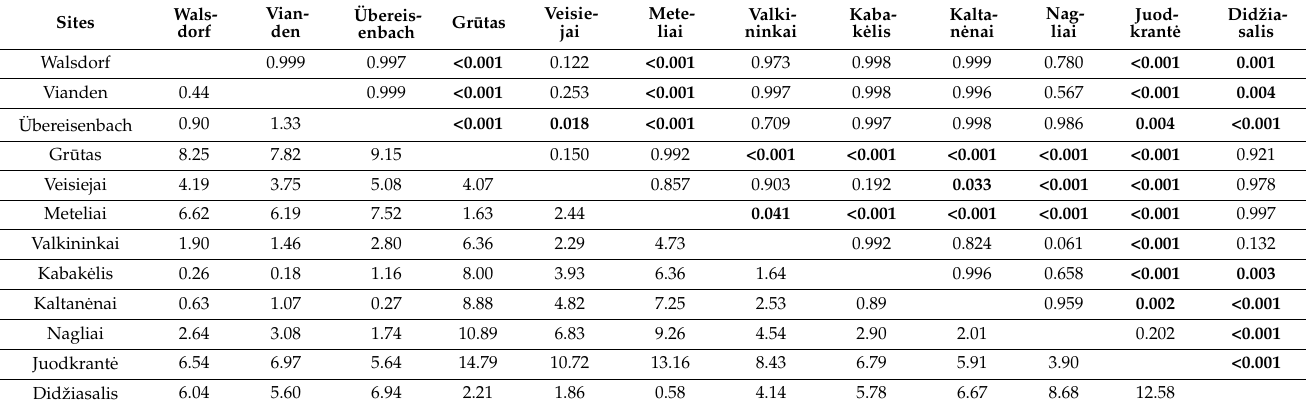
Table A6. Results of pairwise comparisons of the pod width between sites using Tukey’s post-hoc test.